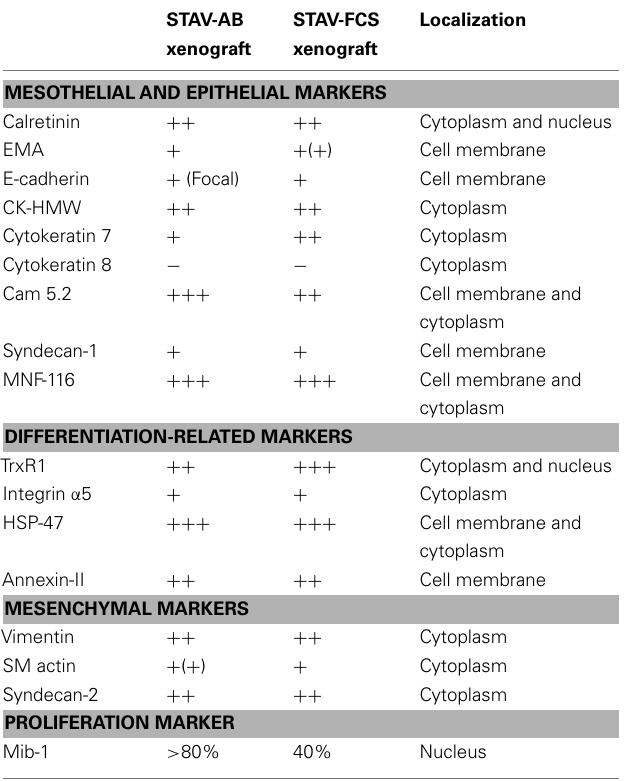
Table 1 | Immunohistochemical analyses of xenografts.